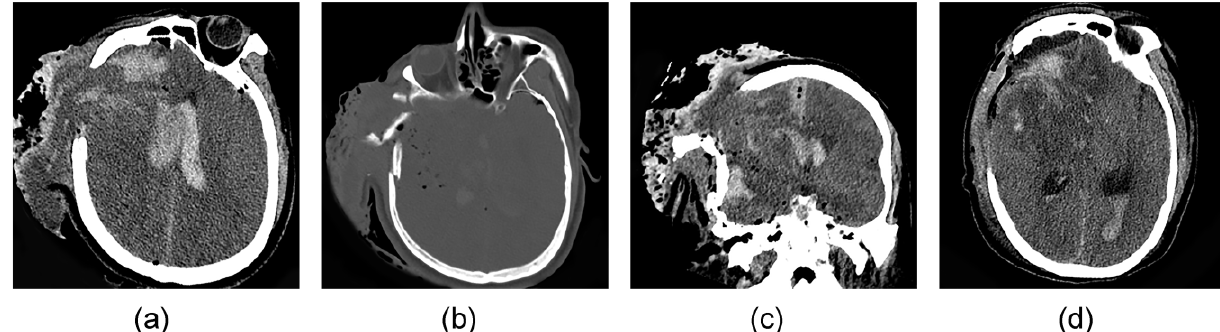
Figure 2. CT images of an open TBI patient with coagulopathy showing brain tissue extravasation, arachnoid hemorrhage and intracranial hematoma in the transverse section ( a ), comminuted frac- ture of right temporal bone and pneumocephalus in the bone window ( b ), subdural hematoma in coronal section ( c ), and re-examination 1 d after decompressive craniectomy showing hematoma and ventricular hematocele ( d ).